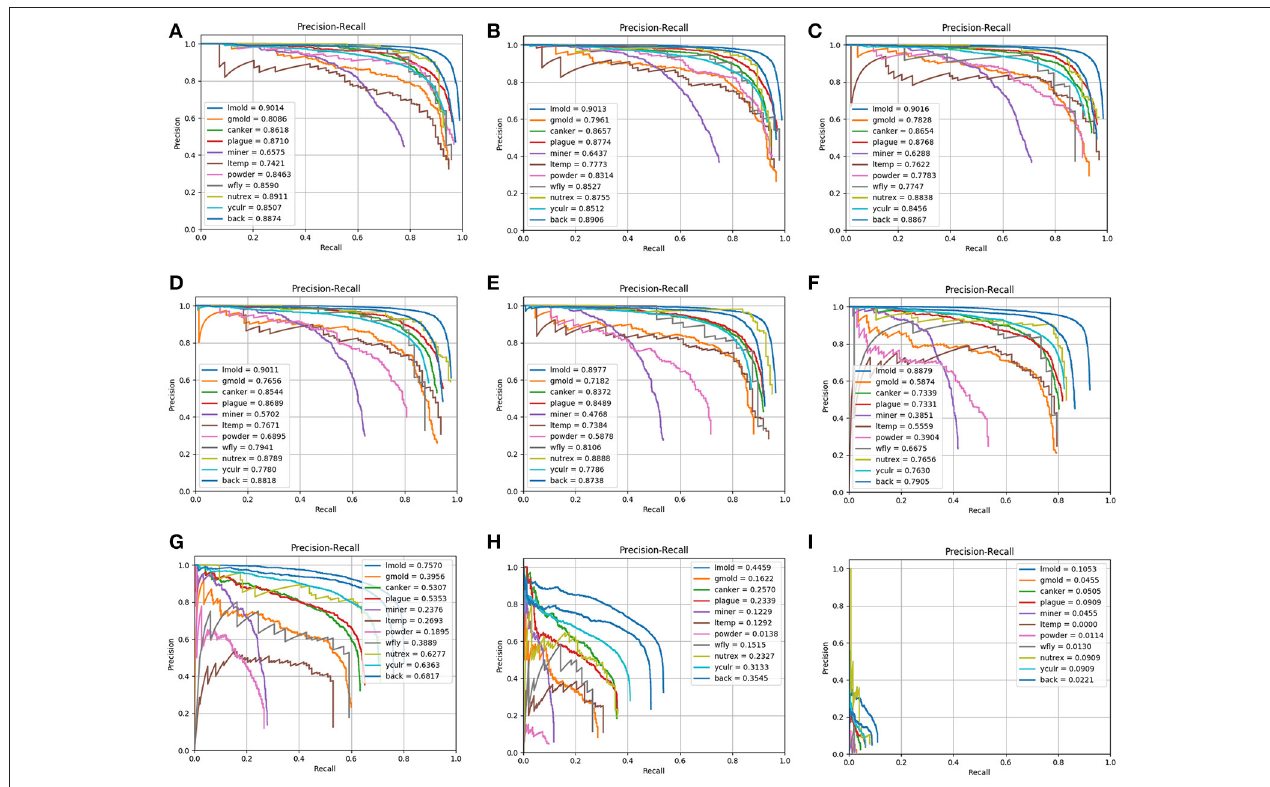
FIGURE 6 | Precision-Recall curves of the primary diagnosis unit (bounding box generation) for different IoU threshold values: (A) 0.1; (B) 0.2; (C) 0.3; (D) 0.4; (E) 0.5; (F) 0.6; (G) 0.7; (H) 0.8; (I) 0.9. Note that the performance decreases as the IoU value is increased.